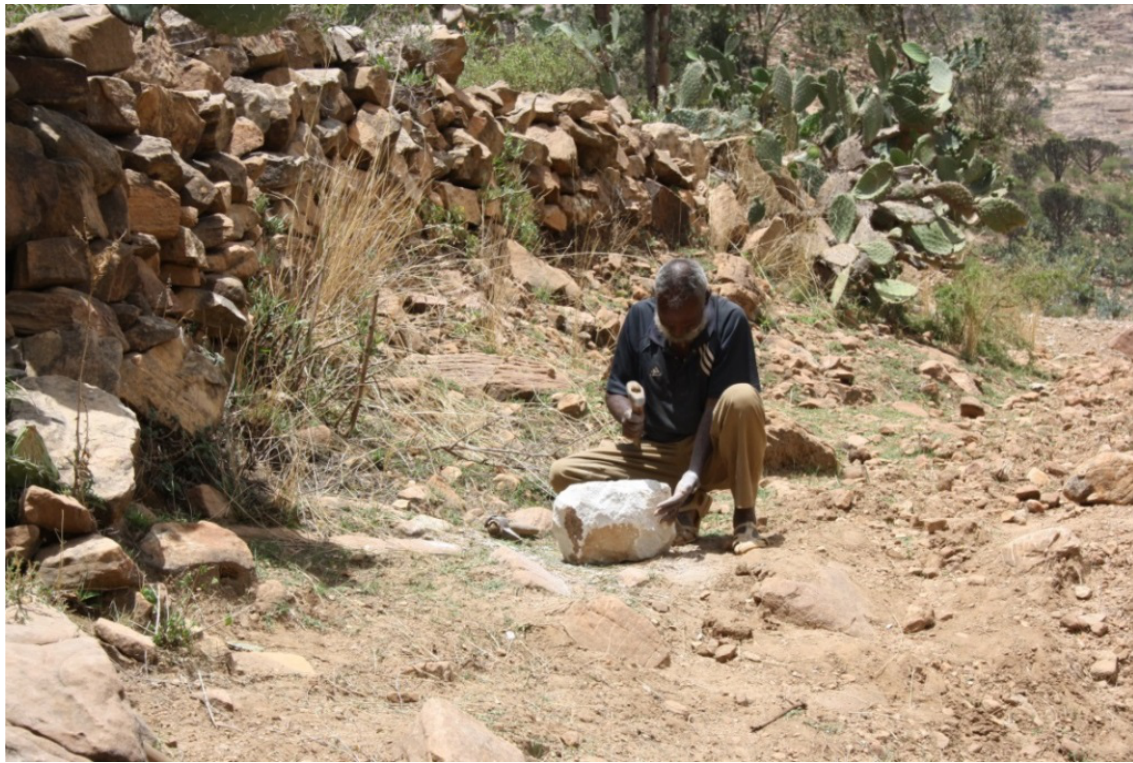
Figure 11. Haleka Gebreselassie Gebreyesus working on final finishing of Mațhan.